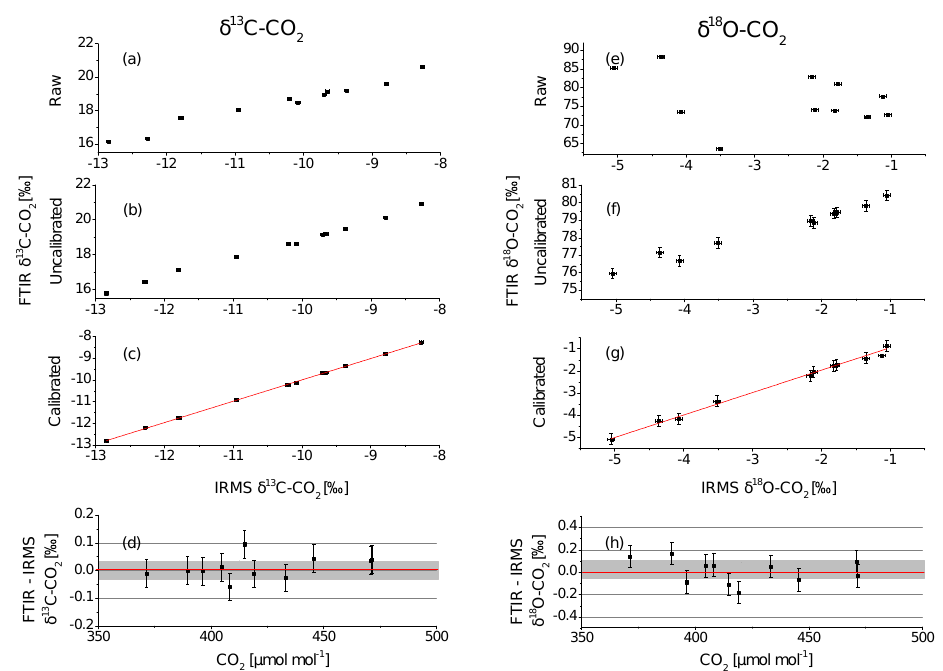
Figure 3. (a) Raw, (b) cross- and interspecies corrected (but still un-calibrated) and (c) calibrated δ 13 C-CO 2 measurements and (e) raw, (f) cross- and interspecies corrected (but still un-calibrated); (g) calibrated δ 18 O-CO 2 measurements of different target cylinders against the IRMS measurement of the same cylinders. Lowest panels: (d) calibrated FTIR δ 13 C-CO 2 value minus reference value measured by the Heidelberg IRMS, (h) same as (d) for δ 18 O-CO 2 , both plotted versus the CO 2 mole fraction of the samples. The red lines in the lowest panels give the mean difference between the FTIR and the IRMS measurements. Grey areas illustrate the standard deviation of the